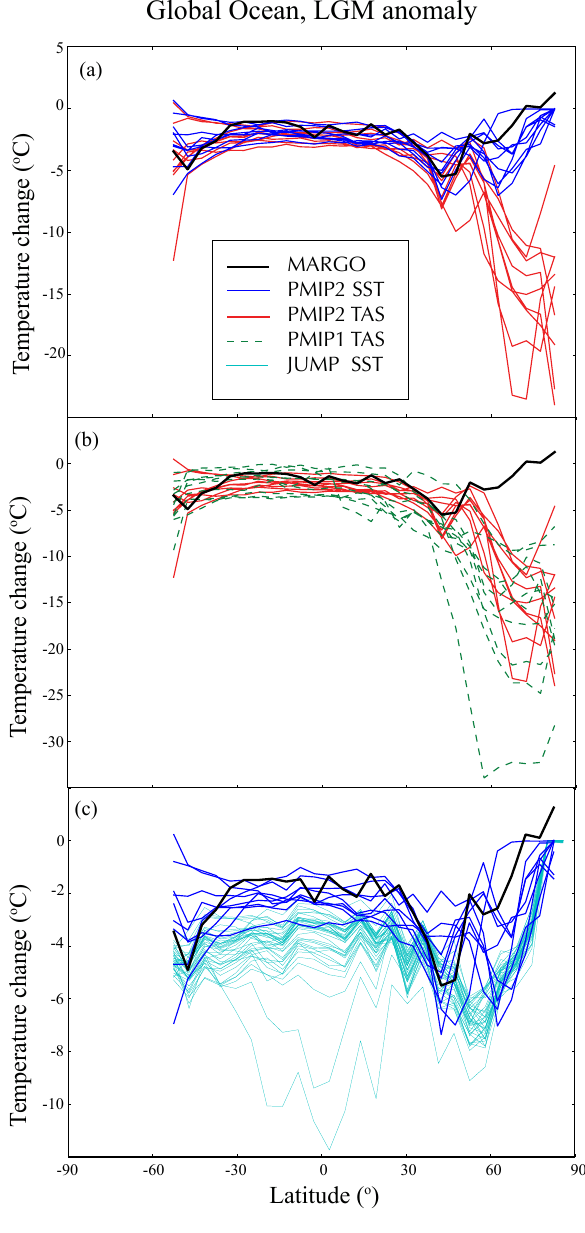
Fig. 2. The LGM anomaly for PMIP2 SST, PMIP2 TAS and PMIP1 TAS, and the MARGO data. As explained in the text, the PMIP model output is interpolated onto the MARGO grid. The zonal means are made by averaging only over the grid boxes for which there are MARGO